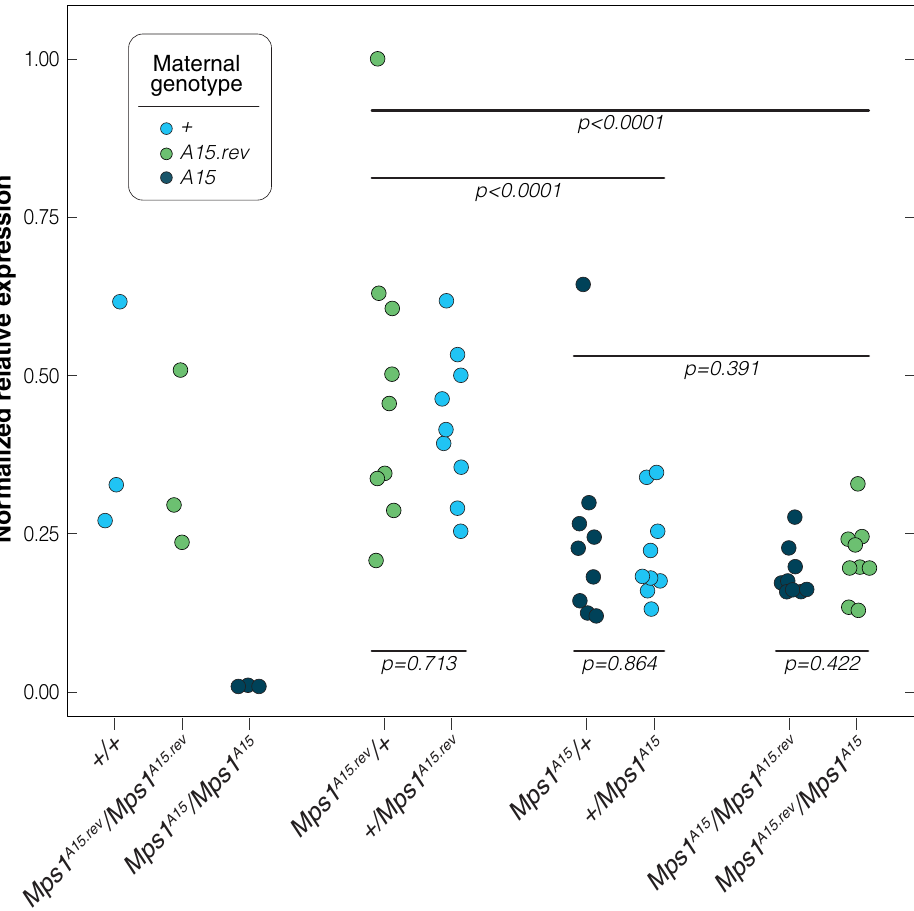
Fig 5. The insertion of the Hobo element alters local RNA expression of intronic and exonic sequence. A) qPCR was performed on random hexamer cDNA generated from ovary total RNA. Values were normalized to rp49 and maximum value for each amplicon made equal to 1 to enable analysis of relative expression. Upstream and Downstream 1 PCR amplicons are intronic and immediately flank the Hobo insertion. Downstream 2 amplicon is derived from an exon sequence. The Hobo insertion alters local expression by increasing transcript abundance of intronic sequence immediately upstream of the insertion, but decreases transcript abundance downstream. B) Model for disruption of Doc triggered silencing of Mps1 . The presence of the Doc element within the alt transcript triggers the formation of a dual-strand cluster that spreads into Mps1 . The Hobo insertion blocks processivity of the alt transcript, presumably through transcriptional termination. In this case, the Doc insertion is no longer a target for cluster formation. https://doi.org/10.1371/journal.pgen.1010598.g005 there is no maternal effect on either silencing or de-silencing. This indicates that genic piRNAs generated from one allele neither silence nor de-silence through a maternal effect or zygotically in trans , though maternal Doc and Hobo piRNAs may certainly play an important role in establishing the silencing in the first place. Additionally, +/ Mps1 A15 . rev genotypes have similar